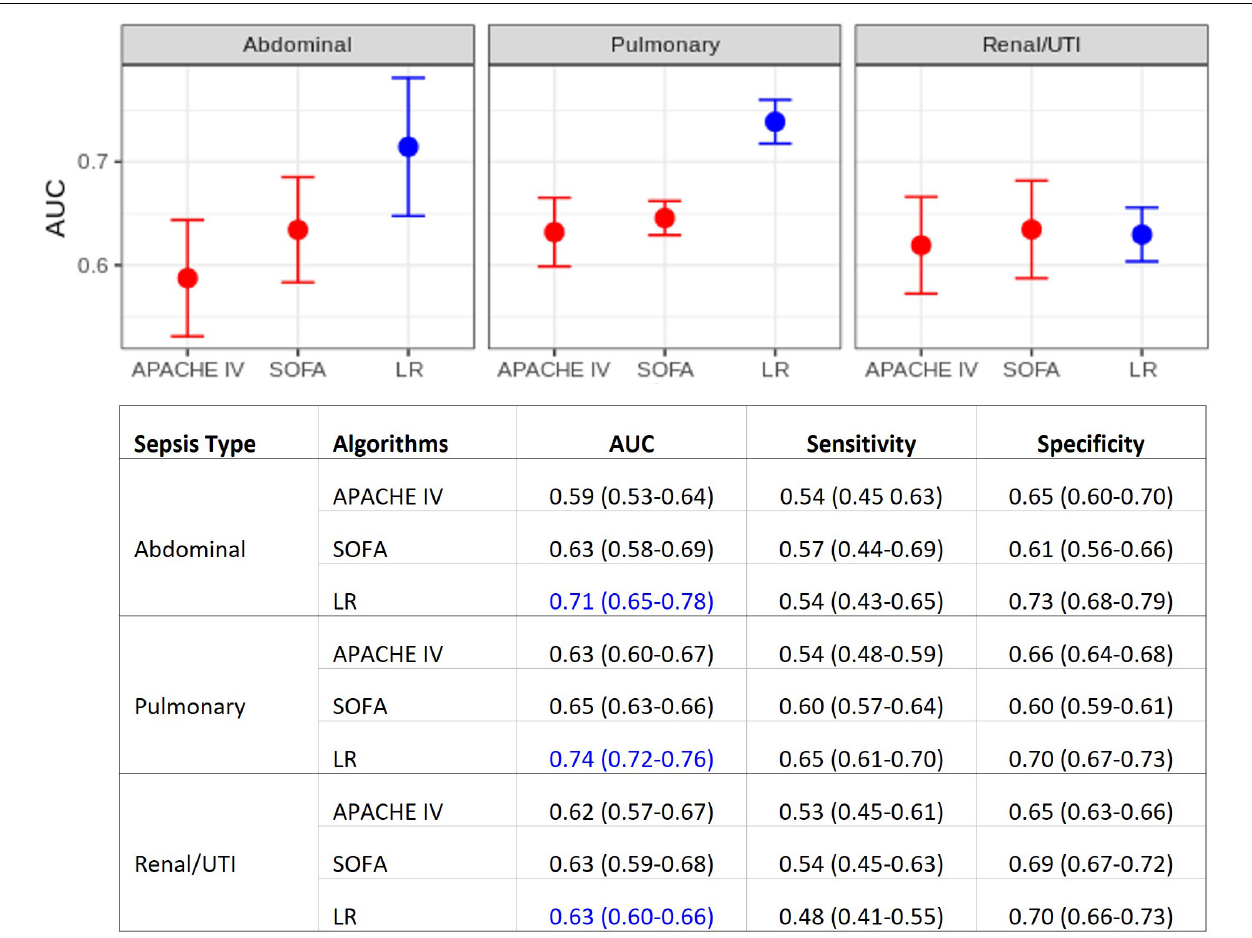
Frontiers in Medicine |